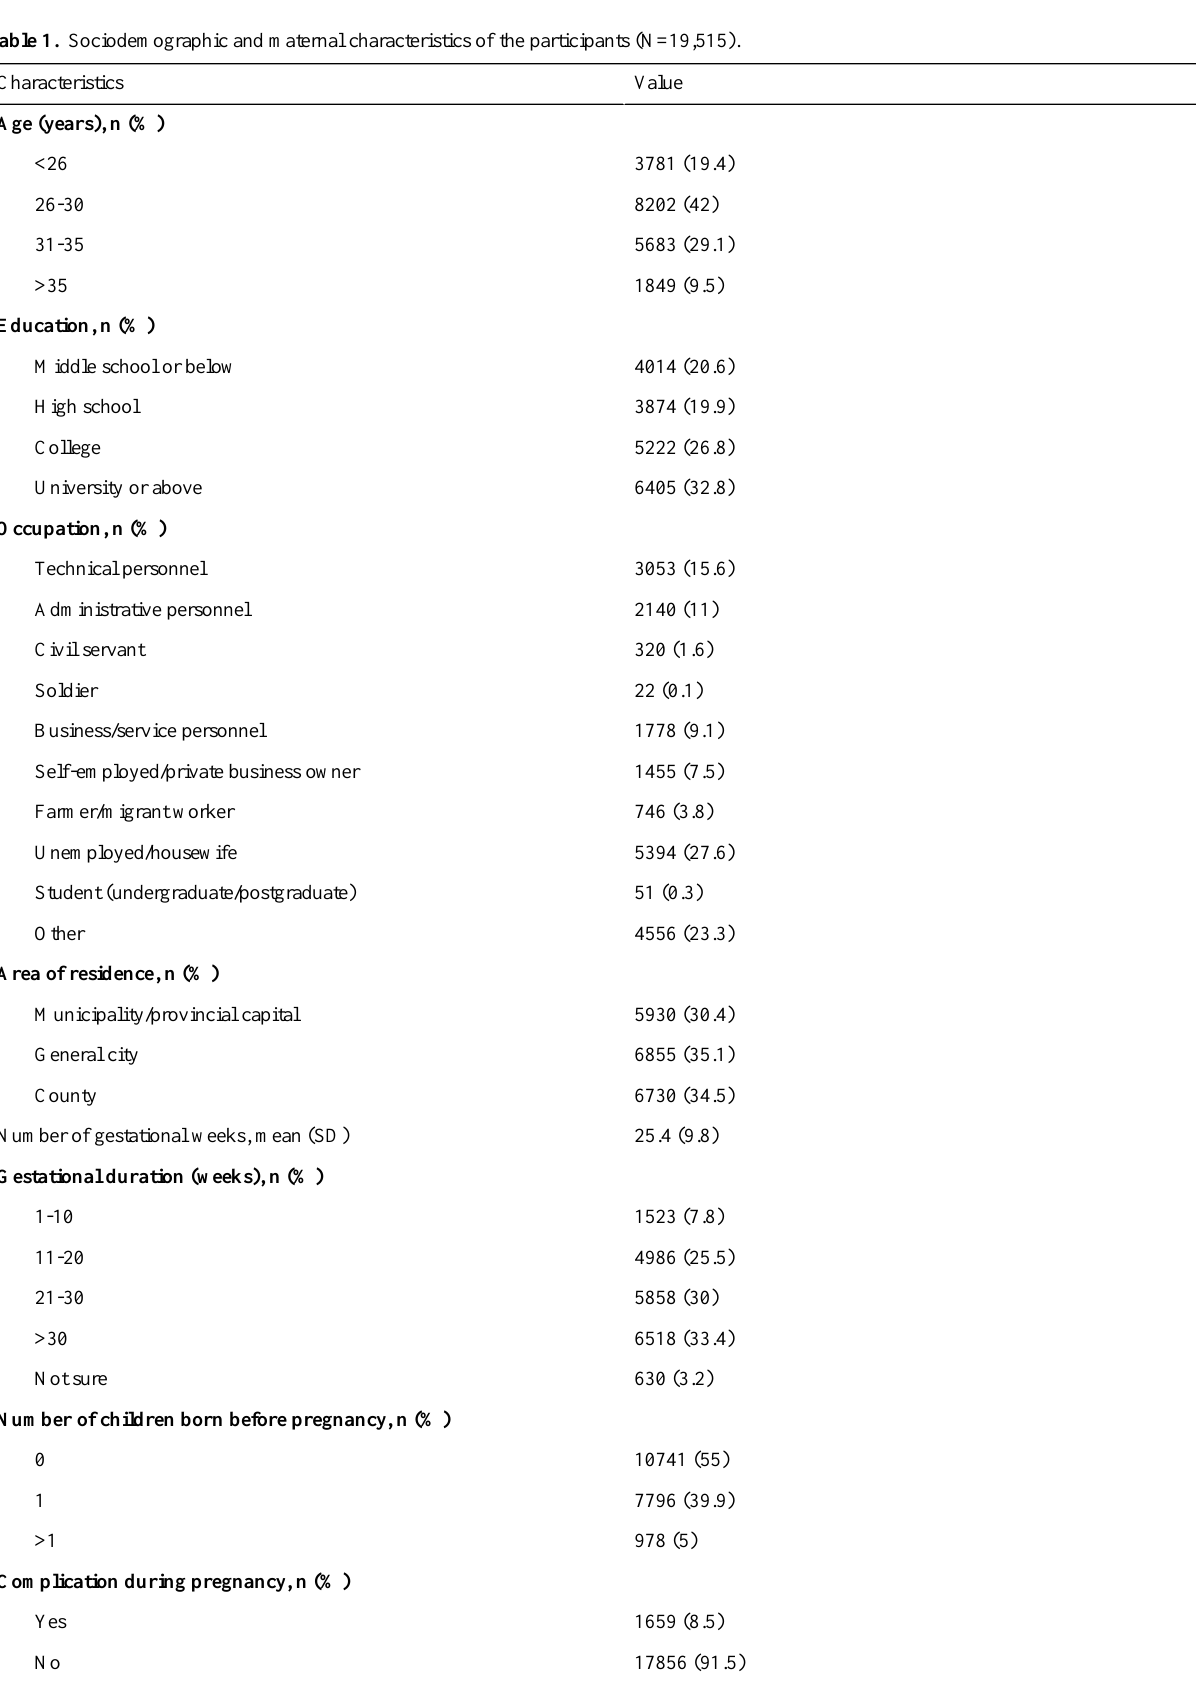
Table 1. Sociodemographic and maternal characteristics of the participants